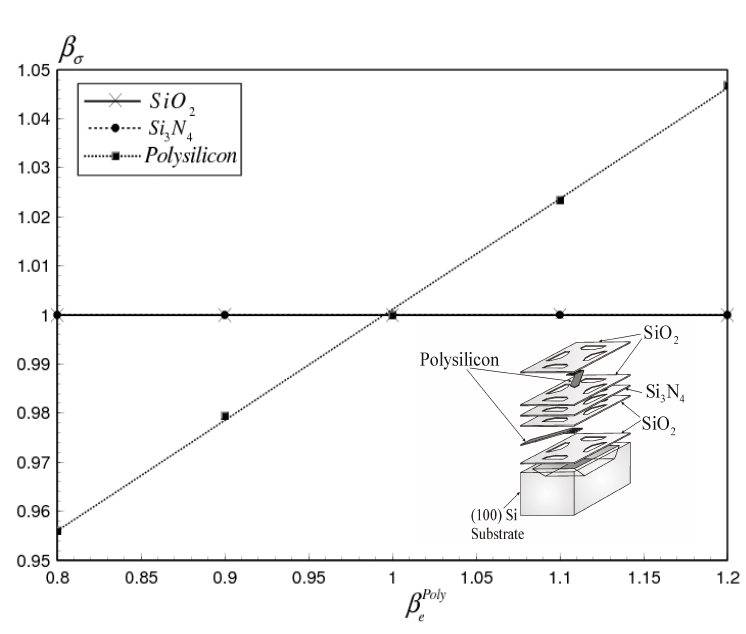
Figure 10. Effect of the variation of the coefficient of thermal expansion of polysilicon on the maximum thermal stress of different gas sensor materials